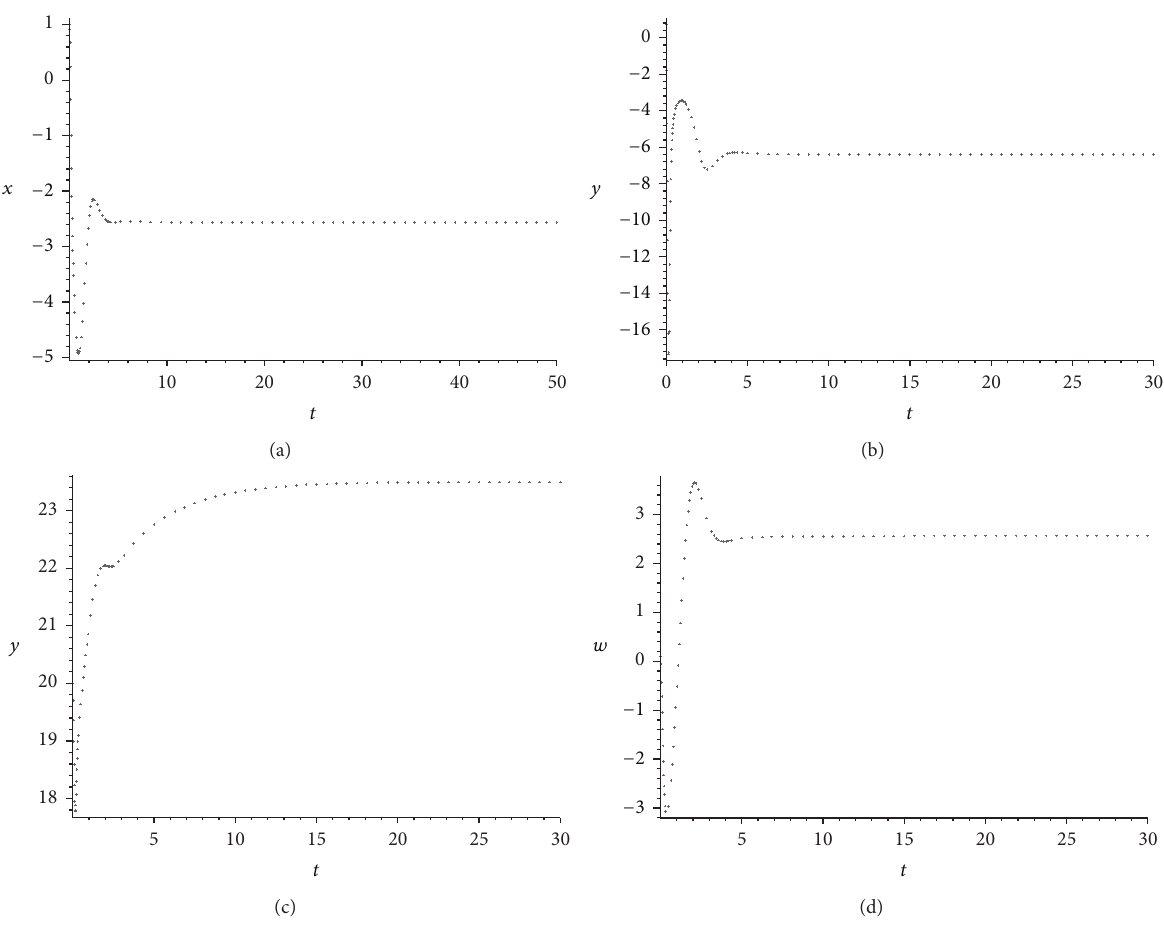
Figure 4: The states of system (19): (a) 𝑥 - 𝑡 , (b) 𝑦 - 𝑡 , (c) 𝑧 - 𝑡 , and (d) 𝑤 - 𝑡